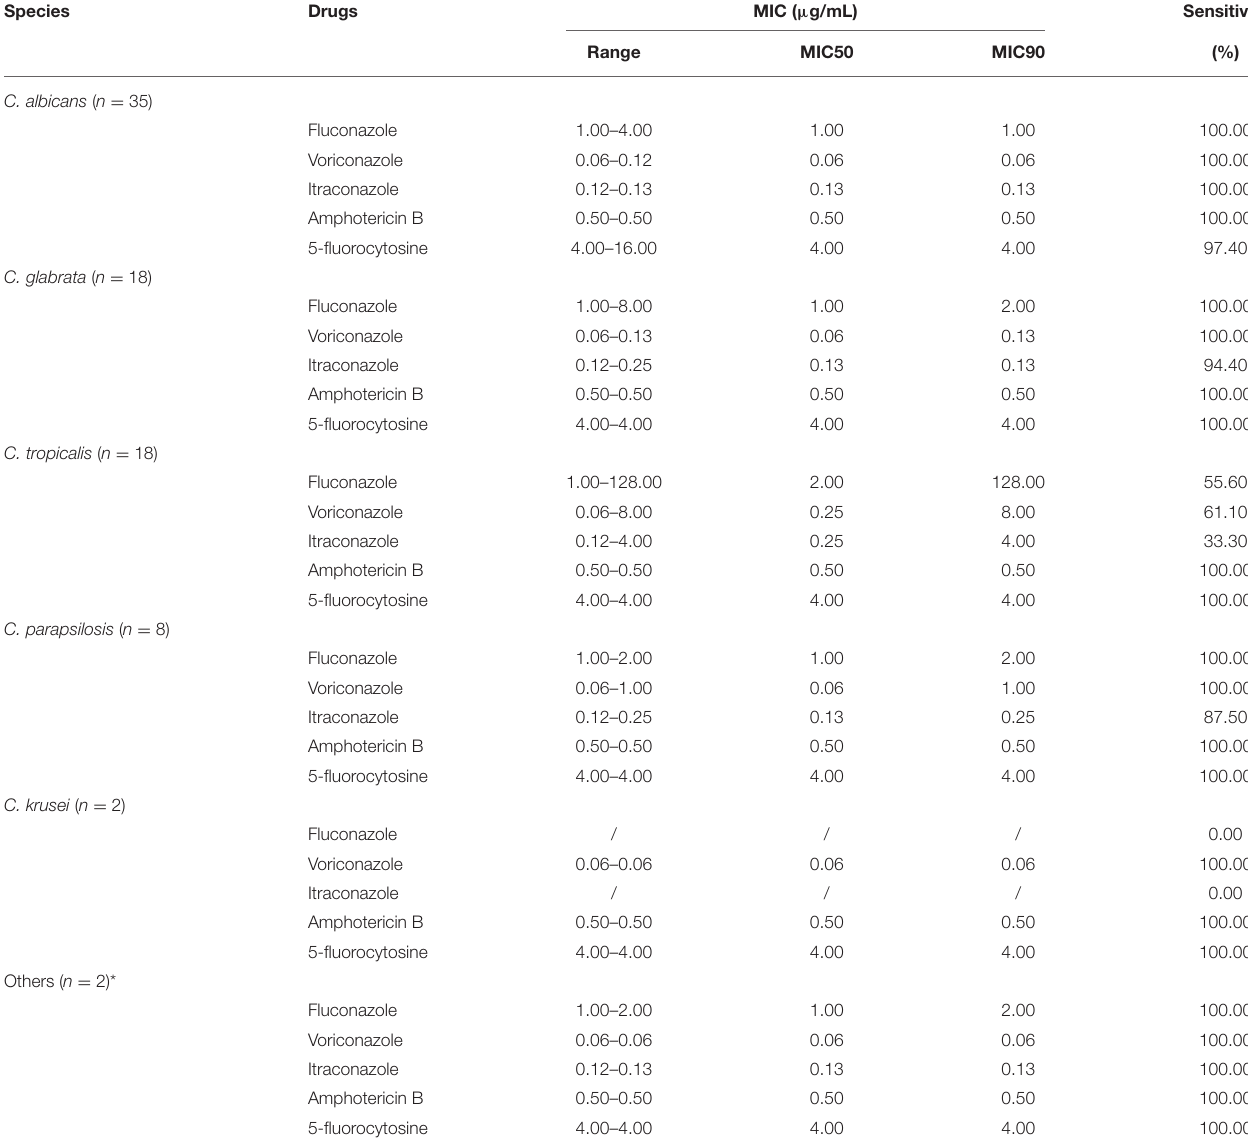
TABLE 1 | In vitro effects of antifungal drugs on the isolated strains of Candida species. Species Drugs MIC ( µ